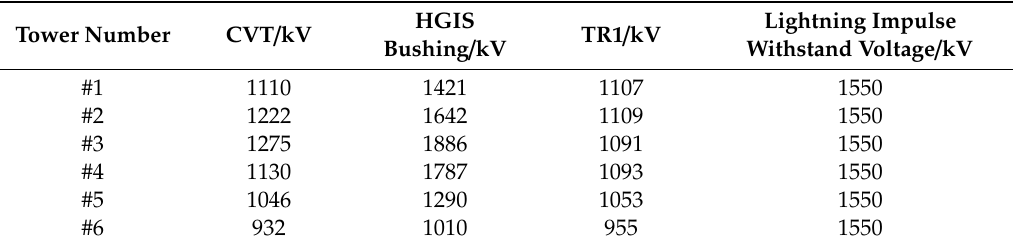
Table 11. Simulation results of the maximum voltage on the equipment.